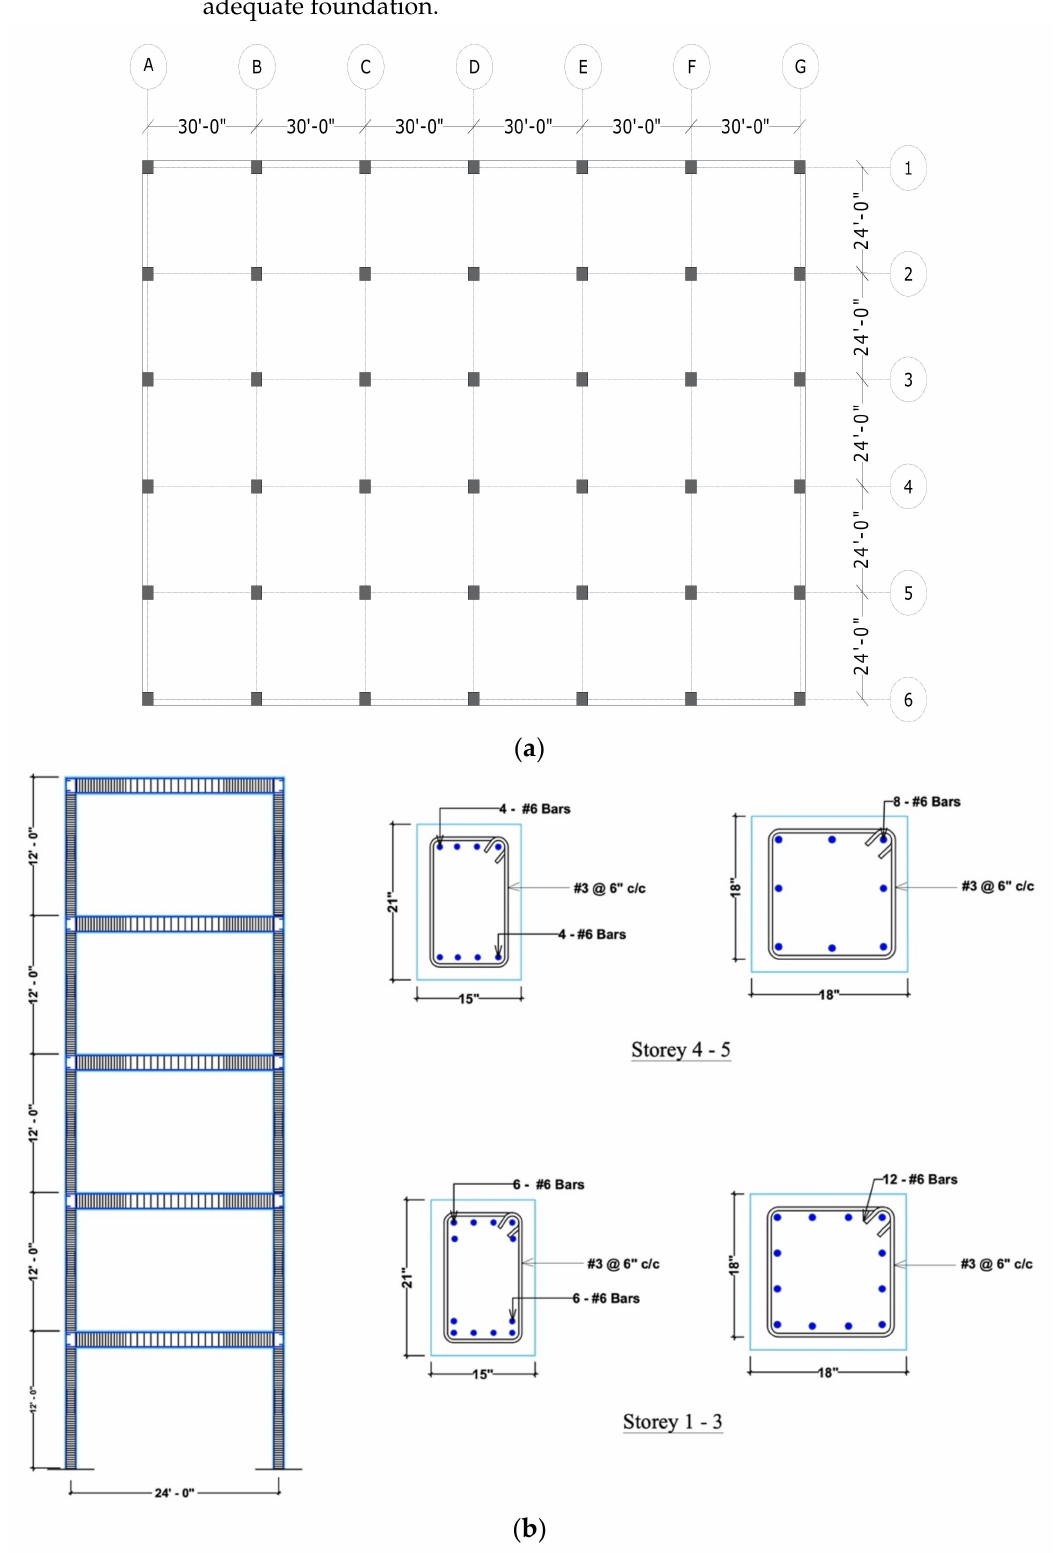
Figure 17. Geometric and reinforcement details of the selected frame. ( a ) The footprint of the considered building and ( b ) one-bay multi-story frame extracted for nonlinear response